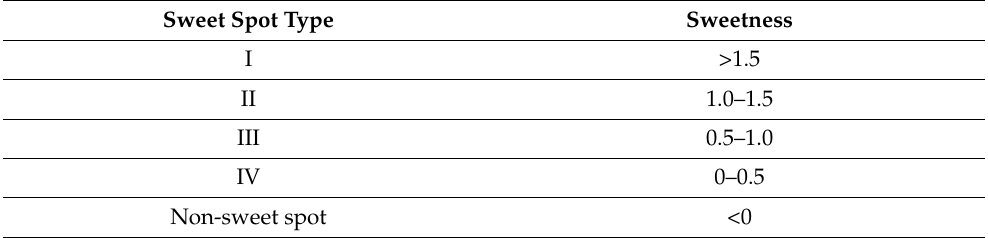
Figure 8. Evaluation results of geological sweet spots, engineering sweet spots and comprehensive sweet spots in the study area: ( a ) sweetness of 3D geological sweet spots based on evaluation indexes of geological sweet spots; ( b ) sweetness of 3D engineering sweet spots based on evaluation indexes of engineering sweet spots; ( c ) evaluation results of 3D comprehensive sweet spots based on the combination of geological sweet spots and engineering sweet spots; ( d ) sweetness of 3D comprehensive sweet spots directly based on the evaluation indexes of geological sweet spots and engineering sweet spots (only the sweet spots area is reserved, models visualized by Schlumberger Petrel software). Table 4. Sweet spots division standard based on sweetness in study